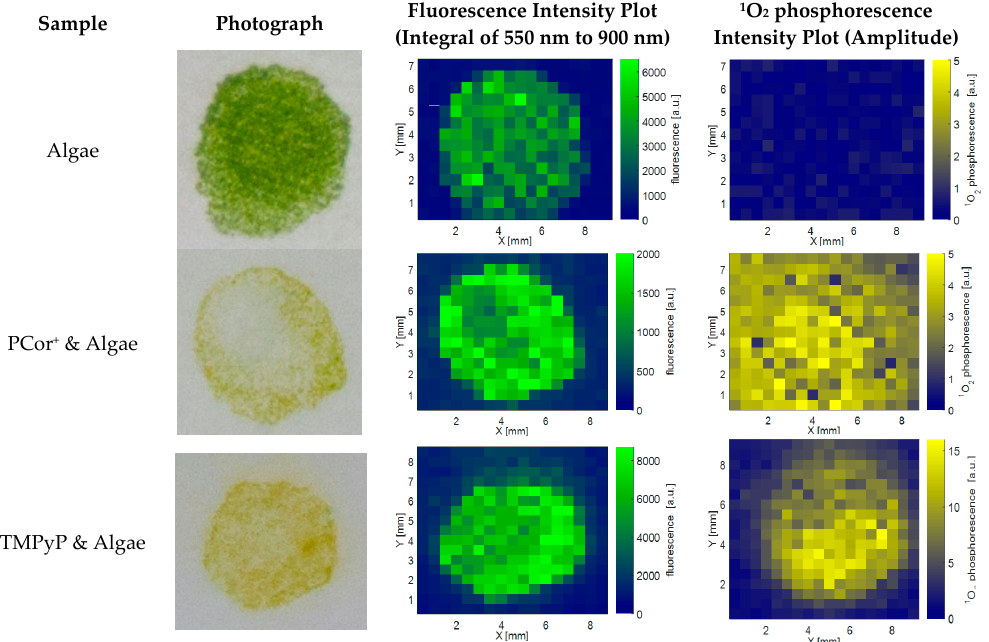
Figure 1. Comparison of the photographs, fluorescence intensity plots and singlet oxygen intensity plots of all samples. As expected, the algae reference does not display any 1 O 2 phosphorescence. The TMPyP-algae-sample shows high spatial correlation of the photograph, and both the fluorescence and 1 O 2 phosphorescence intensity plots. Interestingly, the 1 O 2 phosphorescence intensity plot of the PCor + -algae-sample appears to contradict the fluorescence intensity plot and the photograph.